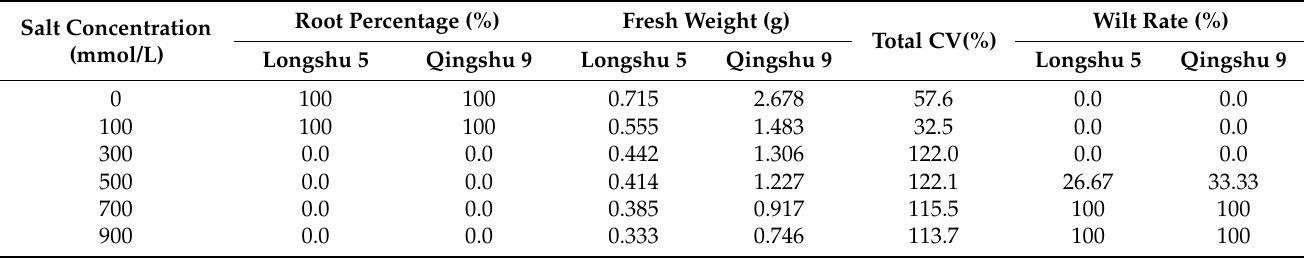
Table 1. Growth parameter analysis under different salt shock concentrations within 96